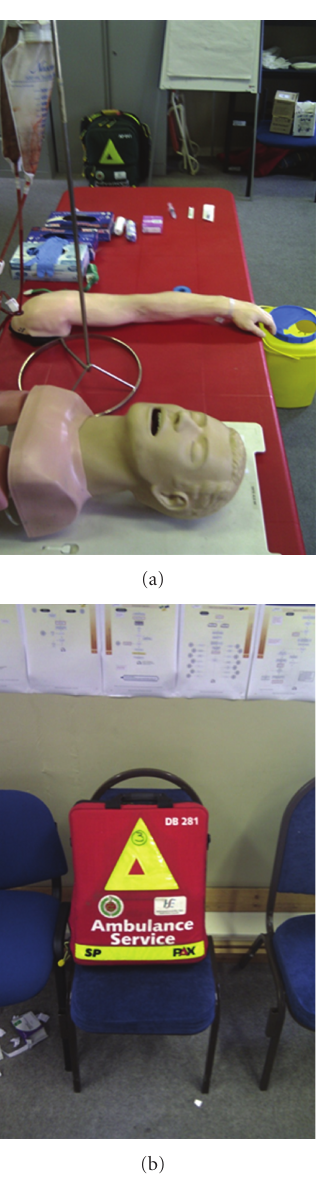
Figure 2: Materials used to carry out classroom-based study in the National Ambulance Services Centre.